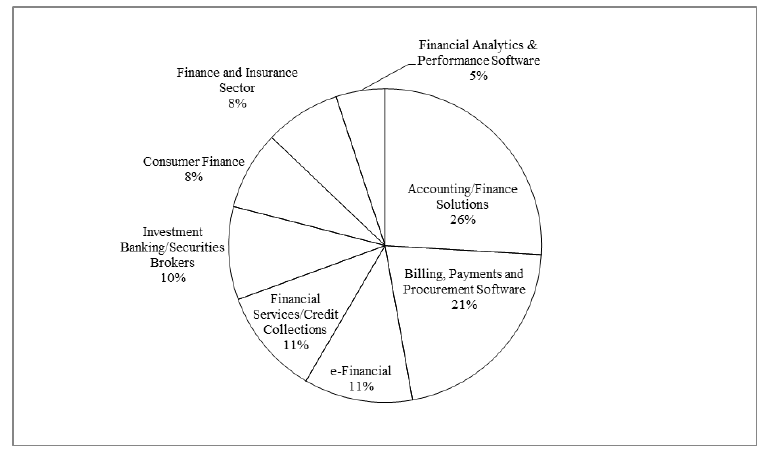
Figure 1. The percentage of investment in fintech by sector in the A group countries. Table 8. Descriptive statistics for collected data.